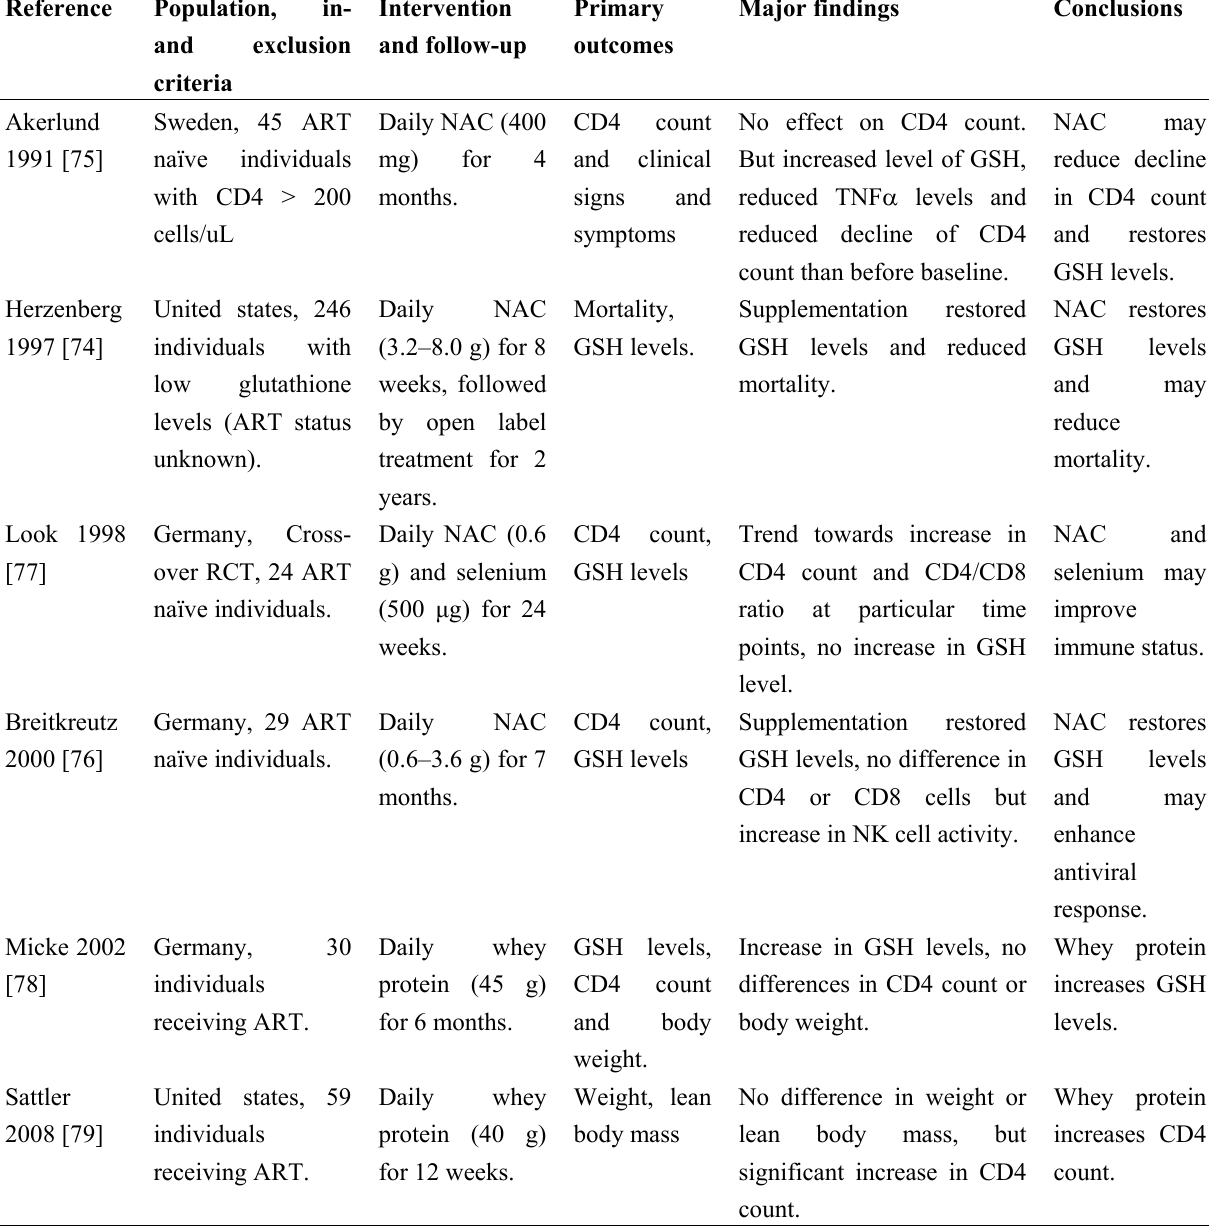
Table 6. Randomized, placebo controlled trial on cysteine and HIV